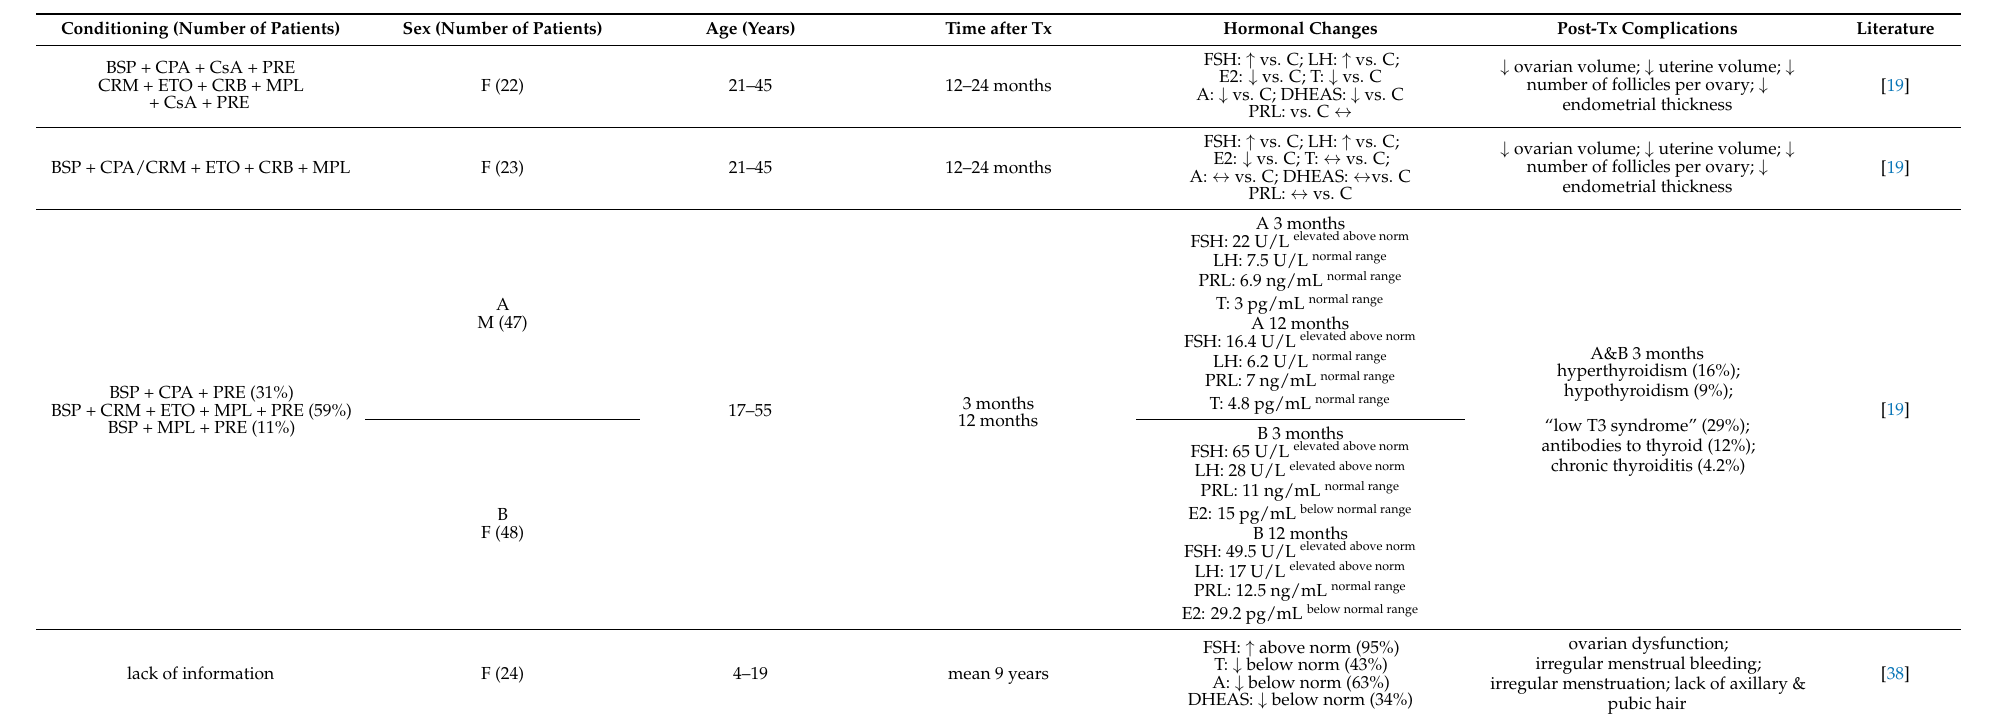
Table 3. Demographical and medical data of bone marrow transplant